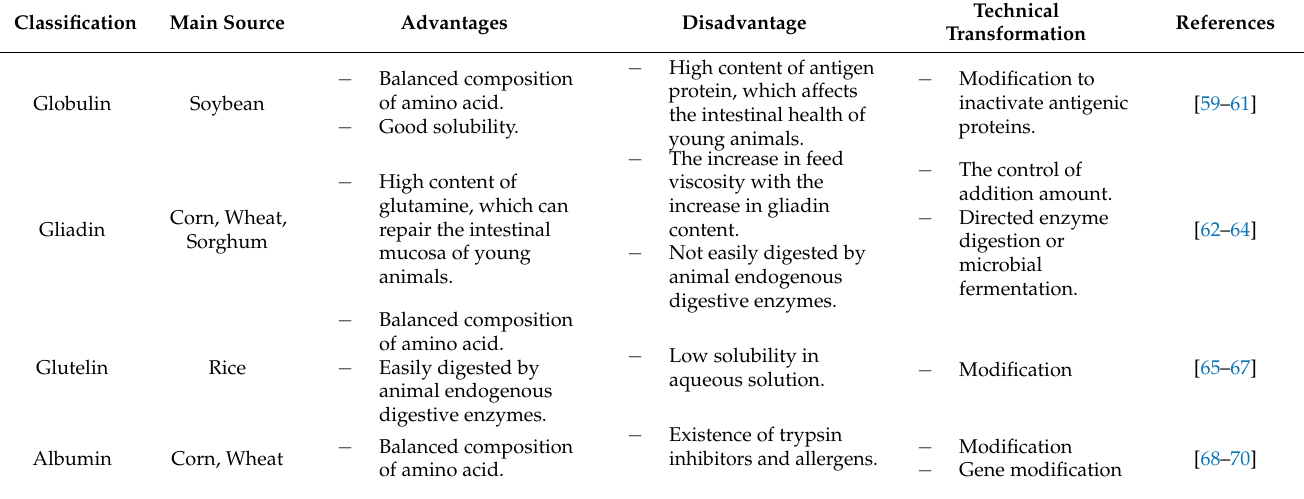
Table 1. Main functional properties of plant protein